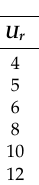
Table 2. Reduced velocity, stiffness ratio, and frequency ratio at Re = 3.8 × 10 4 , for m* = 0.66, 1.32, and